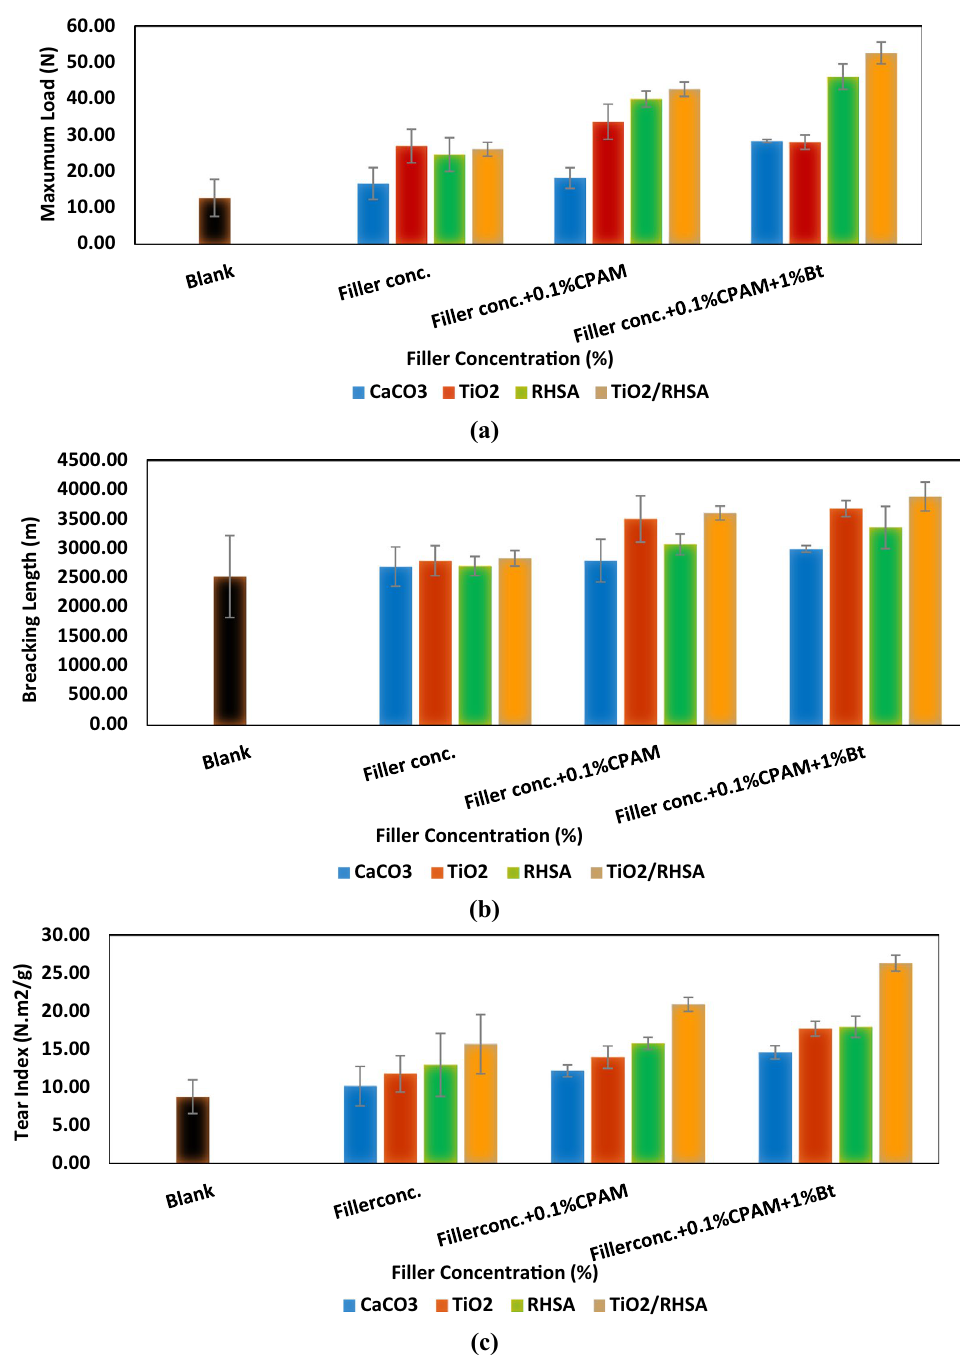
Figure 3. Strength properties for various filler additives in relation with paper composition, ( a ) maximum load, ( b ) breaking length, ( c ) tear index and ( d ) burst